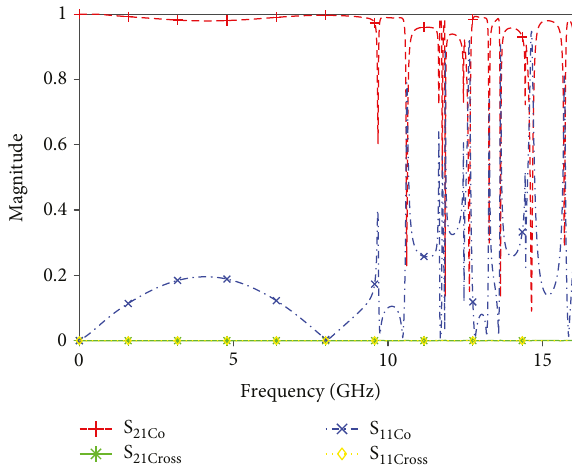
Figure 2: Scattering parameters (magnitude) for a linearly polarized plane wave, normally incident on a single layer chiral honeycomb.